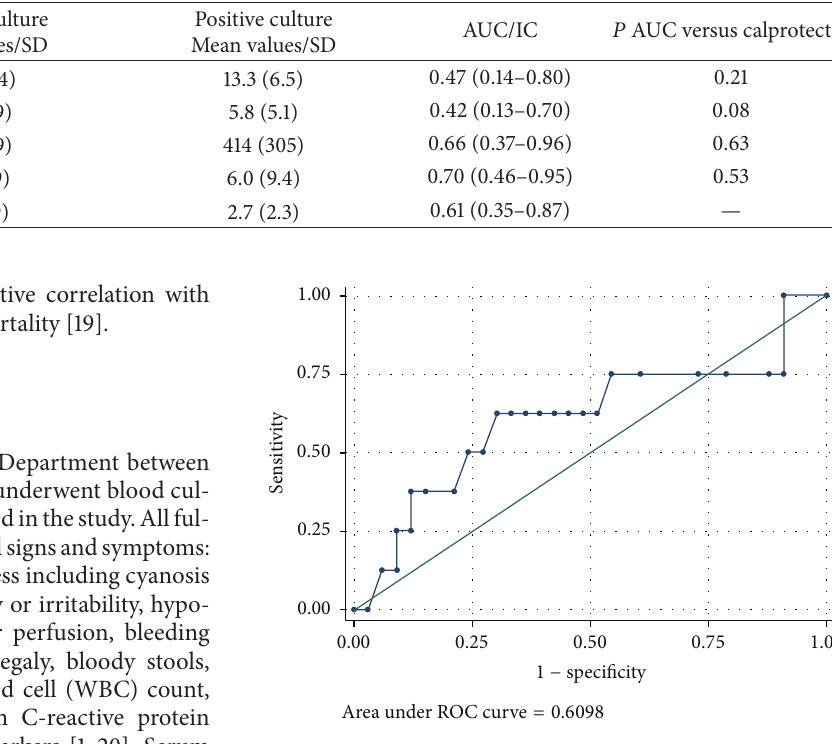
Figure 1: Calprotectin: ROC